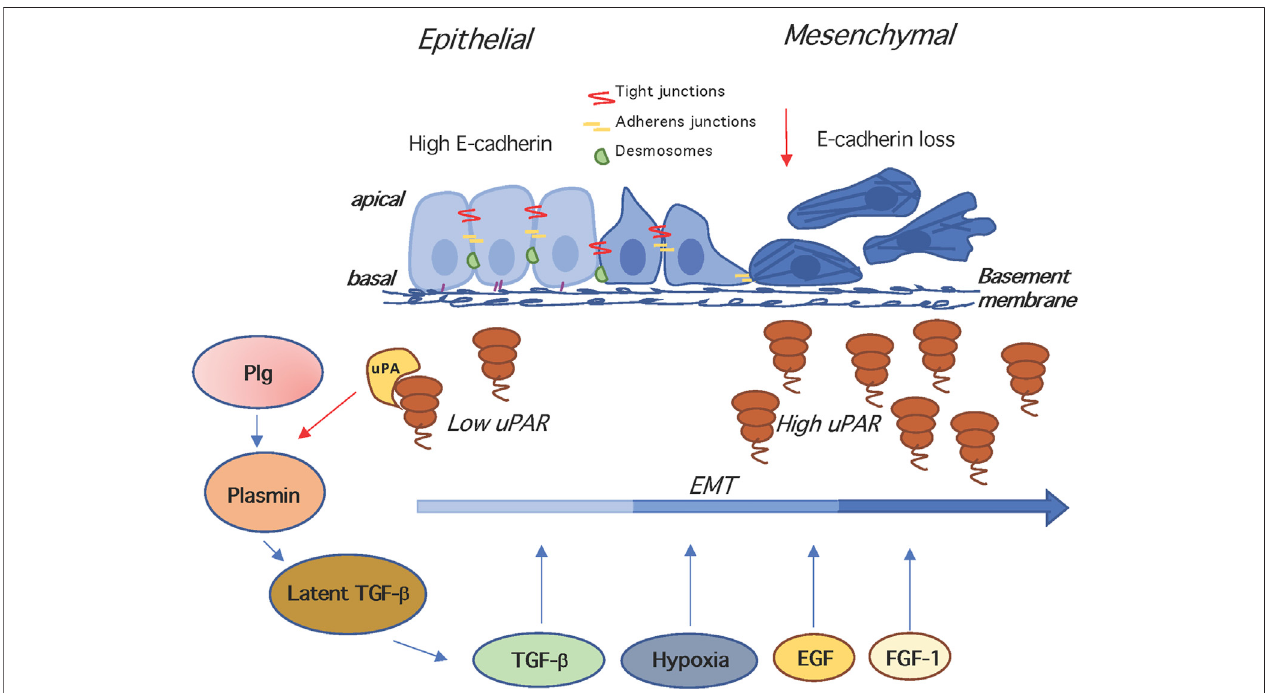
FIGURE 2 | The uPAR and epithelial to mesenchymal transition. In the EMT, epithelial cells lose their junctions and apical – basal polarity, reorganize their cytoskeleton, change their motility/adhesion properties and reprogramme gene expression. EMT is induced by hypoxia, and growth factors like TGF- β , EGF, FGF-1, disrupting of cell-cell junctions and inducing loss of E-cadherin. The uPA- and Plg-dependent activation of latent TGF- β generates active TGF- β that is a potent EMT inducer.BothTGF- β and uPA/uPARareinvolvedintheinductionofEMT,andmutualcooperationmaybeoperating, since TGF- β stimulatestheexpressionofuPA and uPAR,and theenhancement ofuPAlevelsincreases plasminogenactivation, whichinturnactivatesmatrix-associatedlatent complexes. Plg,plasminogen;TGF- β , Transforming growth factor beta.